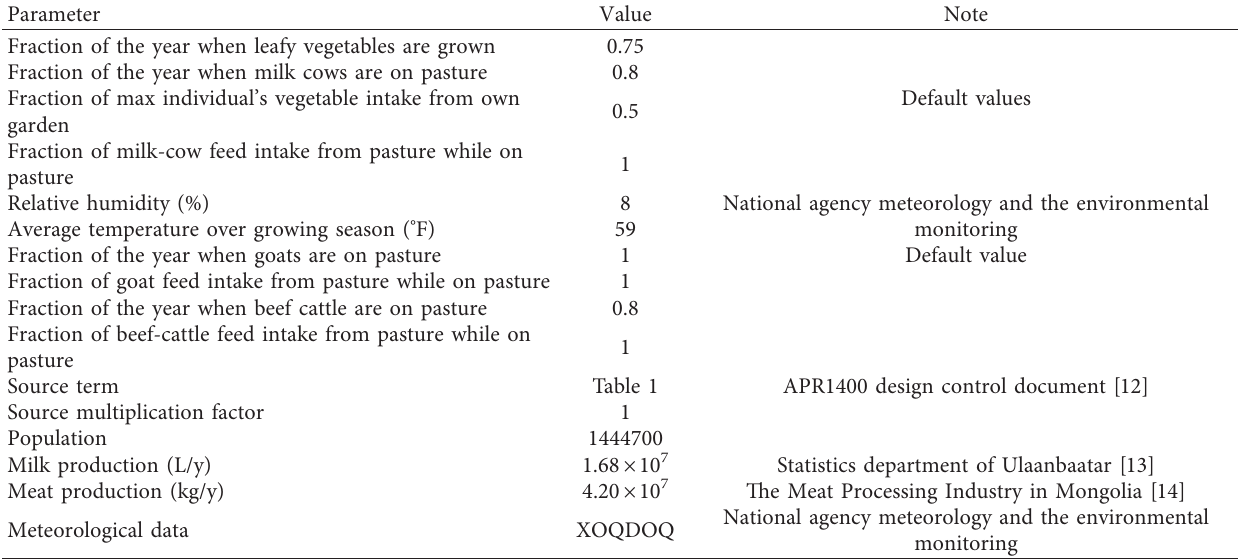
Table 2: Input parameter for GASPAR.